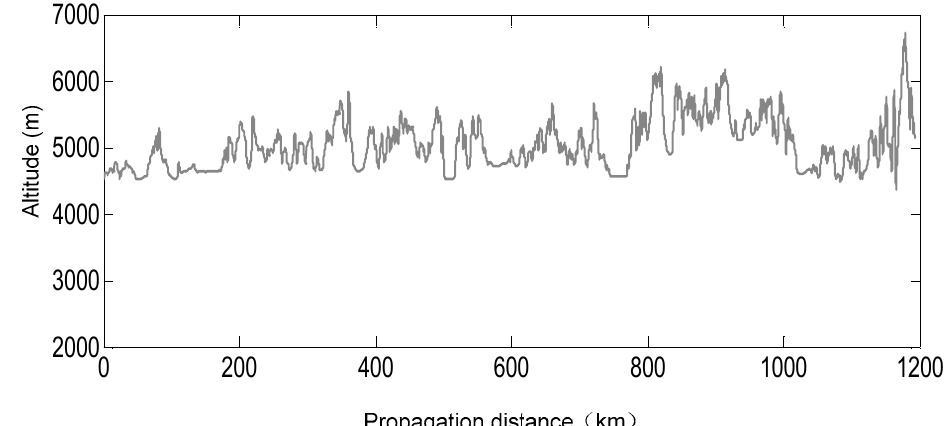
Figure 13. Landform profile of the Naqu region due west.